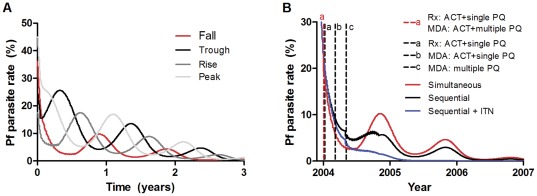
Effect of varying the timing of interventions.
A Varying the season in which interventions are implemented. MDA with ACT+multiple primaquine and Rx with ACT+single primaquine started together at different times during the malaria season: when parasite prevalence is falling, at trough, rising or at peak. B Simultaneous versus sequential interventions and the additional effect of bed nets. Simultaneous introduction of treatment with ACT+single primaquine plus MDA with ACT+multiple primaquine (red) versus optimally timed sequential interventions (black): a. treatment with ACT+single primaquine then b. MDA with ACT+primaquine at 9 weeks before the nadir and c. another MDA with multiple primaquine at the nadir and the same simultaneous interventions with the addition of long lasting insecticide treated bed nets with 30% coverage (blue).